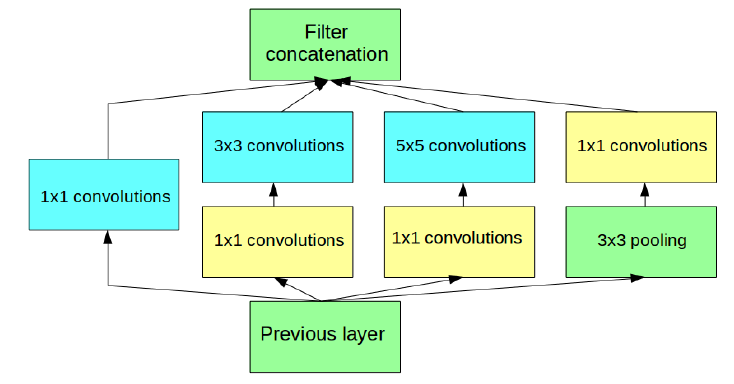
Figure 1. Illustration of Inception module. It was restricted to filter sizes 1 × 1, 3 × 3, and 5 × 5. Subsequently, the outputs were concatenated into a single vector that is the input for the next stage. Adding of an alternative parallel pooling path was found to be beneficial. Applying filters of 1 × 1 convolution makes it possible to reduce the volume before the expensive 3 × 3 and 5 × 5 convolutions